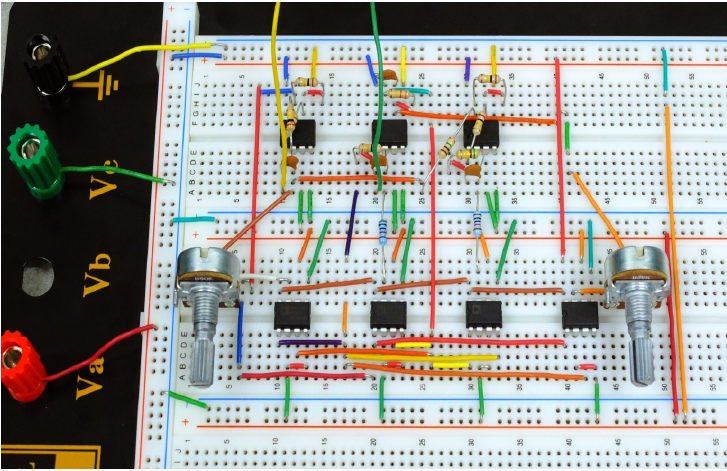
Figure 6. Hardware configurations: real circuit of the four-order Chen–Lee